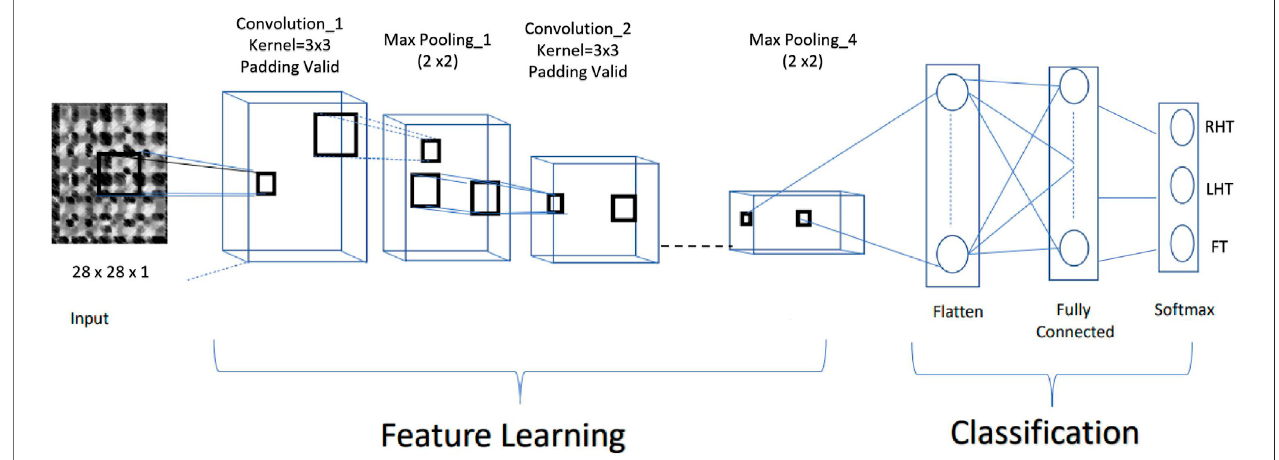
FIGURE 5 | CNN based architecture of the proposed classi fi